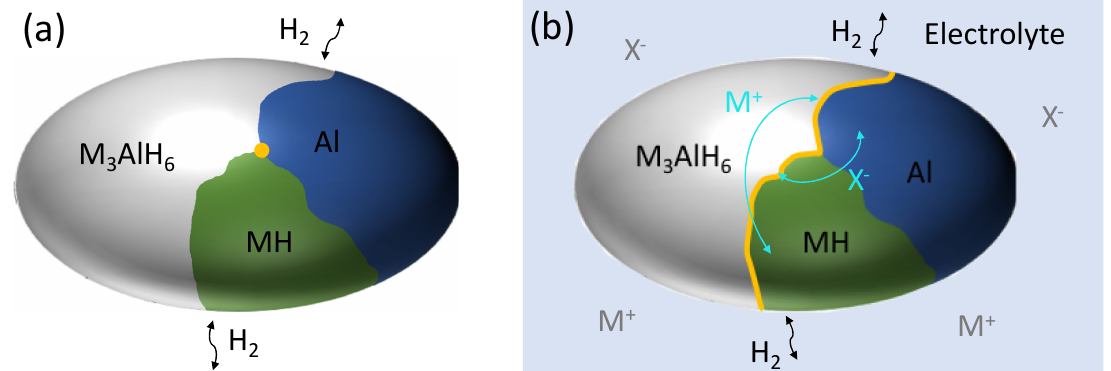
Figure 8. Schematic of a particle in an intermediate state of the second step ( M 3 AlH 6 ← → 3 M H + Al 3/2H 2 ) for ( a ) a solid state (control) particle and ( b ) an electrolyte-treated sample showing possible solubilized species ( M + and X − ) in the bulk electrolyte (grey) and on the surface (light blue). The reactive interfacial area is shown in yellow.